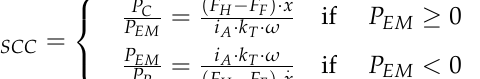
Figure 7. ( a ) Variation of the equivalent system’s mass as function of the piston position; ( b ) and variation of the gravitational load acting on the actuator as function of the piston position.